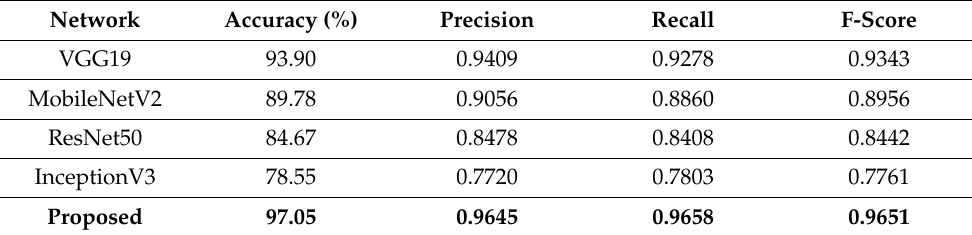
Table 6. Comparison of the proposed framework with standard CNN-based networks. Network Accuracy (%) Precision Recall